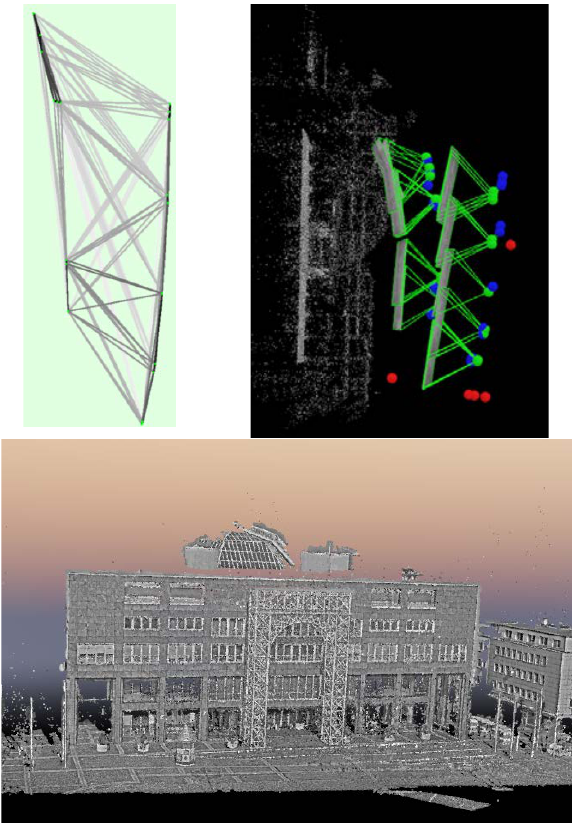
Figure 14: UAV and terrestrial, set a, Wallis-filtered image. Upper left: image connections, upper right: tie point cloud and camera locations (red: not adjusted), lower: densified point